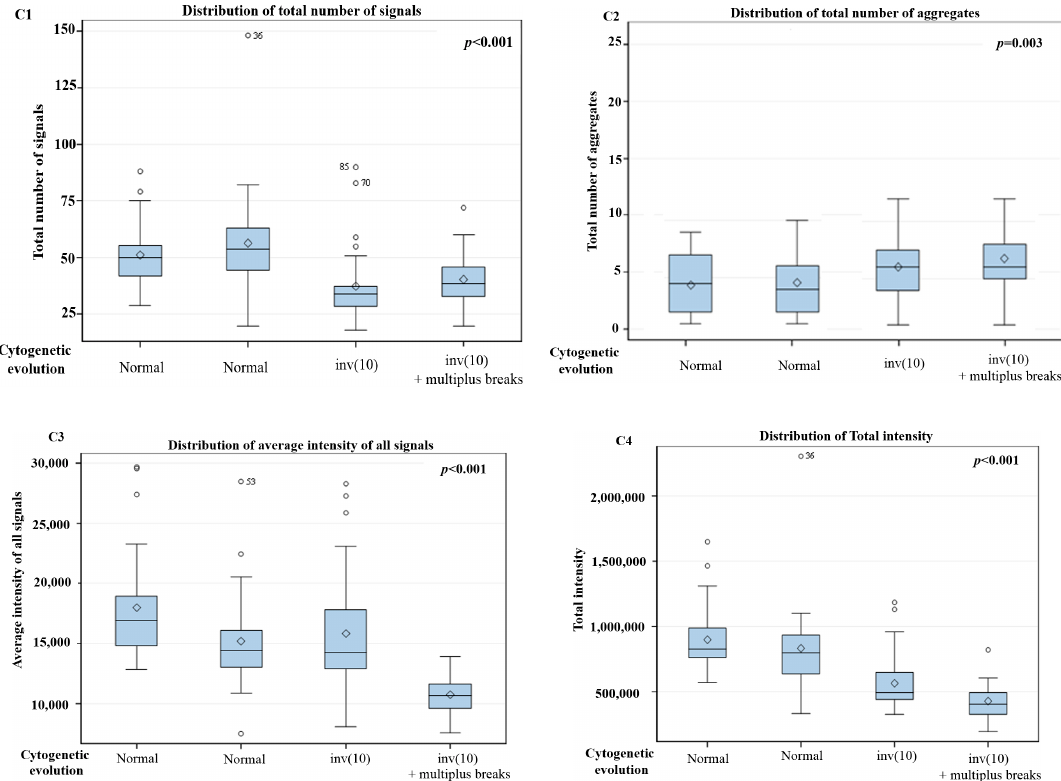
Figure 4. 3D telomere profiling during cytogenetic evolution in MDS—two time points ( A1–A4 ), three time points ( B1–B4 ) and four time points ( C1–C4 ) are shown after comparison of total number of signals, total number of aggregates, average intensity of signal and total intensity. p -values included in each graph indicate the significance when comparing the first sample with the last sample (first time point with last time point collected). p values for all other comparisons are shown in Supplementary Table S2. Patient number 2 (P2) is shown in ( A ), P4 in ( B ) and P1 in ( C ).